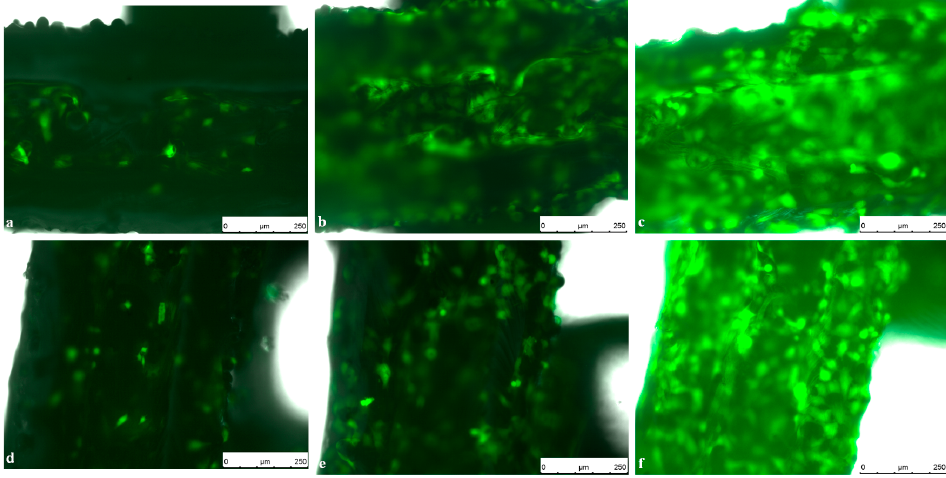
Figure 7. Live Cell Imaging (LCI) of GFP-Osteoblasts seeded on titanium implants on ( a ) Day 1; ( b ) Day 4 and ( c ) Day 7 compared to GFP-Osteoblasts seeded on PCL coated titanium implants on ( d ) Day 1; ( e ) Day 4 and ( f ) Day 7. Pictures were taken in 10-fold magnification using an exposure time of 6 ms, a gain of 5.8 and an intensity of 3 s. Scale bar: 250 µm.